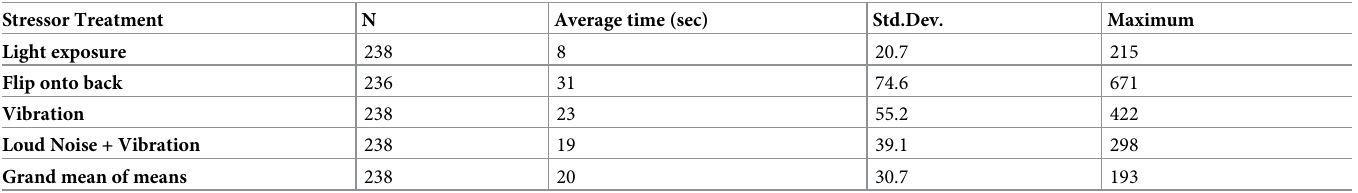
Table 1. Summary of freeze times for different stressor treatments applied to passalus beetles in this study. See text of methods and Fig 2 for descriptions of each treatment. A total of 238 beetles were tested and each beetle underwent all four treatments (but on different days). The four immobility times were averaged for each beetle for statistical purposes. The grand mean shows the average of all 238 averages. Stressor